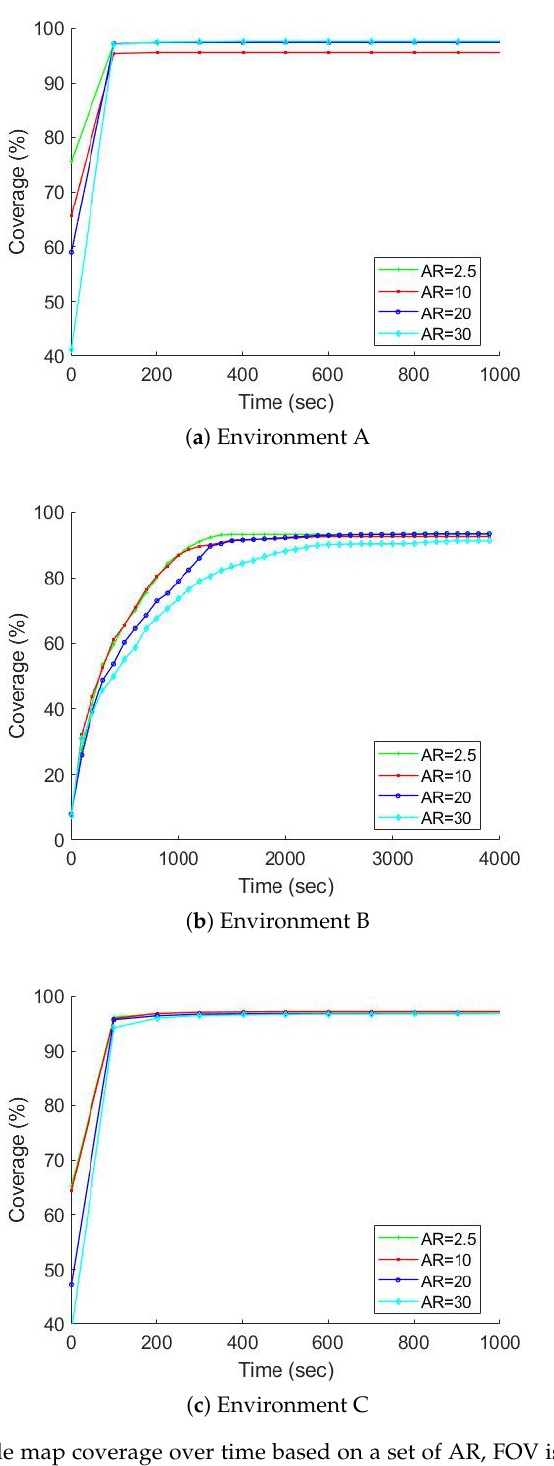
Figure 12. The obstacle map coverage over time based on a set of AR, FOV is equal to 360 degrees, average over ten